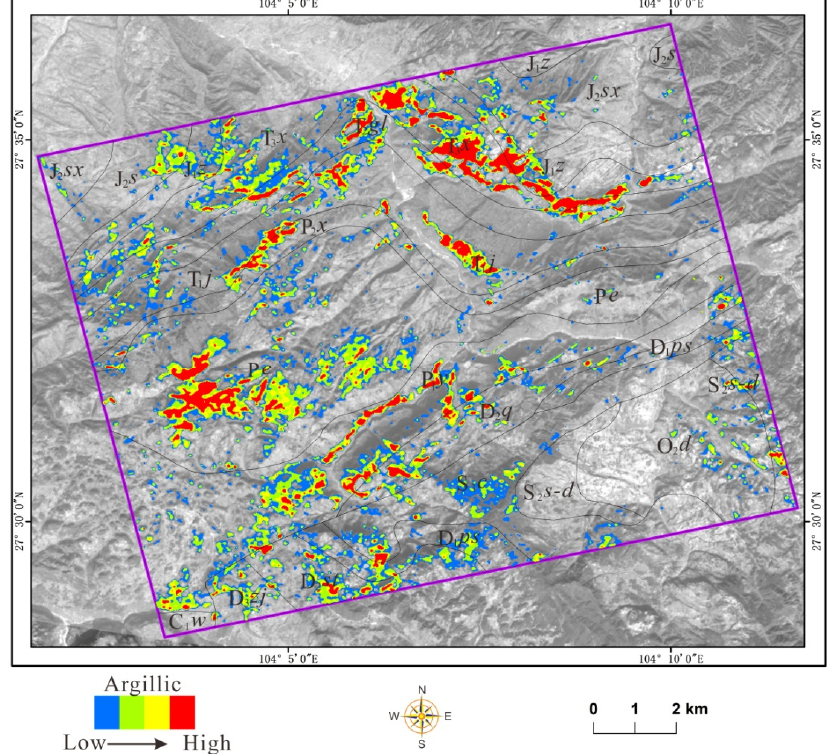
Figure 4. Argillic minerals mapped with ASTER data using SPCA method.